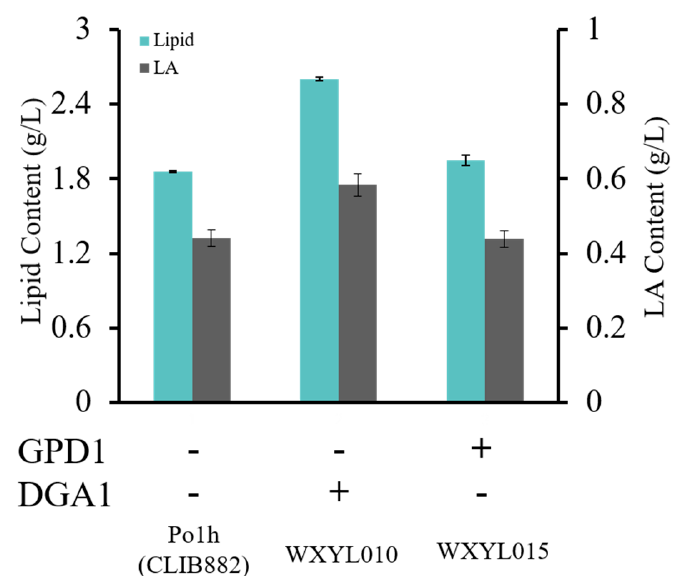
Figure 2. Analysis of strains overexpressing GPD1 or DGA1 . Lipid and LA contents of strains were analyzed after 72 h of culture (C / N mass ratio of 15). Lipid samples were performed in triplicate.